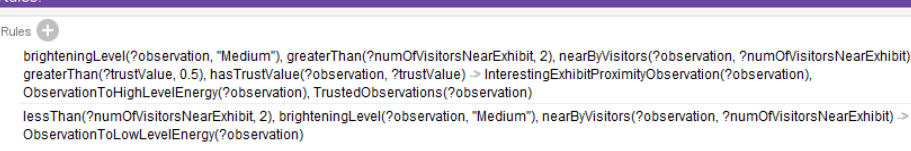
Figure 4. Scenario 1-based SWRL rules in SmartMuseumOnto (depicted in Protégé